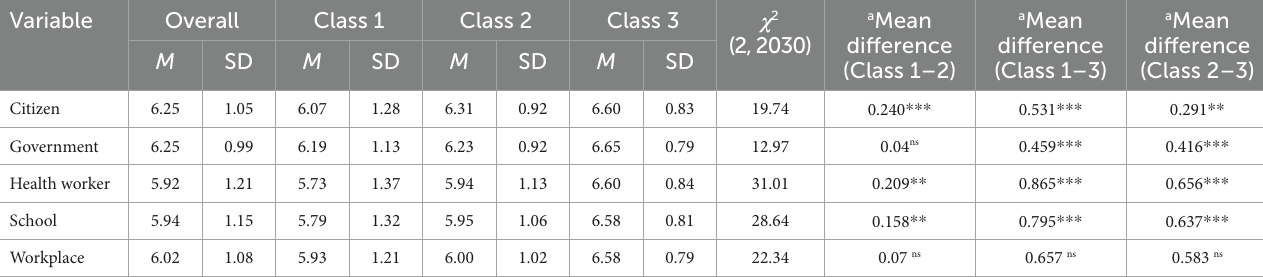
TABLE 7 Attributions of responsibility by each audience